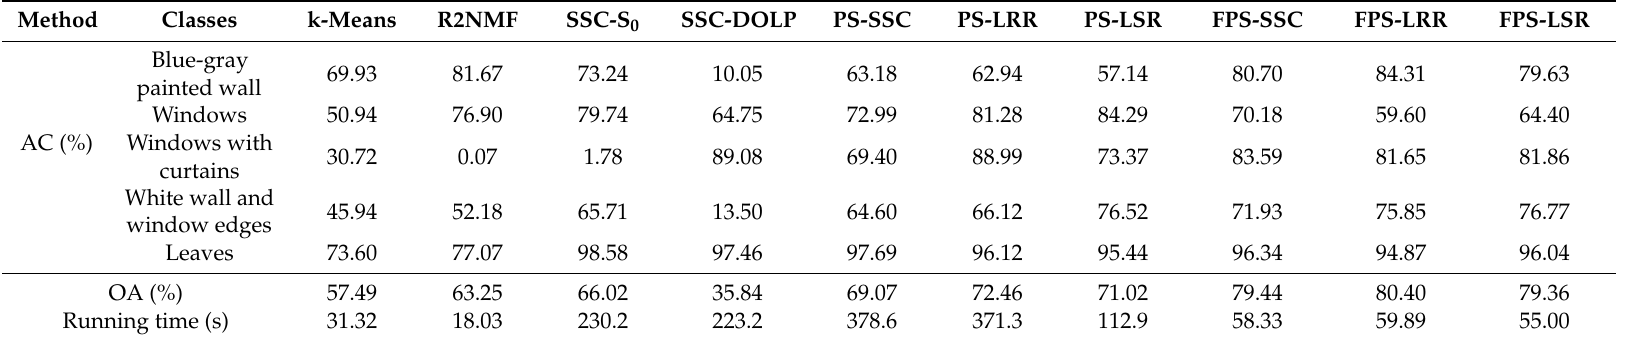
Table 2. Quantitative evaluation of the di ff erent clustering algorithms of dataset A.